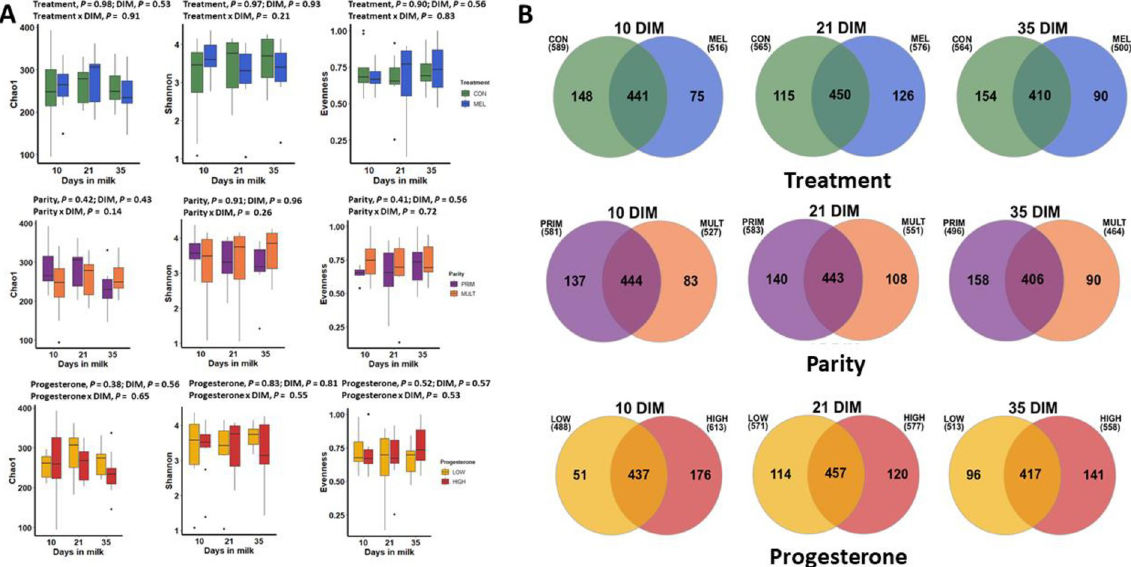
Fig 2. Effects of meloxicam treatment (n = 9, control (CON) and n = 7, meloxicam (MEL)), parity (n = 7, primiparous (PRIM) and n = 9, multiparous (MULT)), and blood progesterone concentration at 35 DIM (n = 10, > 1 ng/mL (HIGH) and n = 6, � 1 ng/mL (LOW)) on the dynamics of the uterine microbiota of clinically healthy postpartum dairy cows (n = 16) in samples collected at 10, 21, and 35 d in milk (DIM). A) Alpha diversity for bacterial genera was not affected by MEL, parity, or progesterone category at 35 DIM (analyzed via mixed linear regression models). B) There number of bacterial core genera (having > 1% abundance) was variable between CON and MEL. PRIM and LOW had more stable, greater numbers of bacterial core genera than MULT and HIGH, respectively.